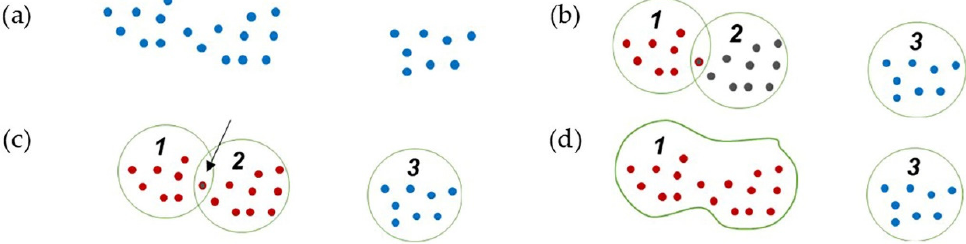
Figure 6. Region growing clustering steps: ( a ) point cloud; ( b ) initial clustering; ( c ) finding common points in two close clusters; ( d ) connecting and joining two clusters.